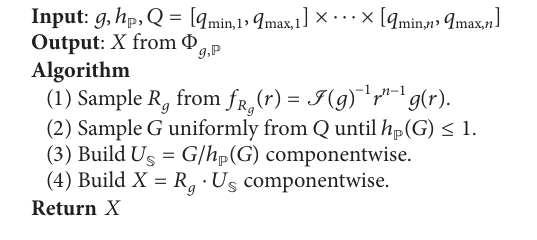
Algorithm 1: Sampling algorithm for polyhedral star-shaped dis- tributions Φ 𝑔, P